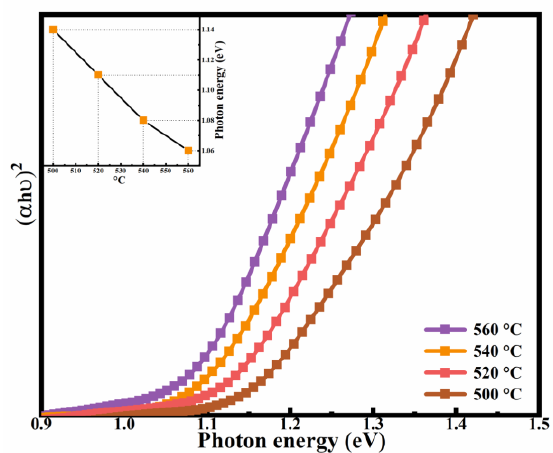
Figure 8. The plot of (αhυ) 2 against hυ for CNZTSSe films selenized at 500 °C, 520 °C, 540 °C, and 560 °C. The insert shows the Eg values of the CNZTSSe films selenized at 500 °C, 520 °C, 540 °C, and 560 °C.